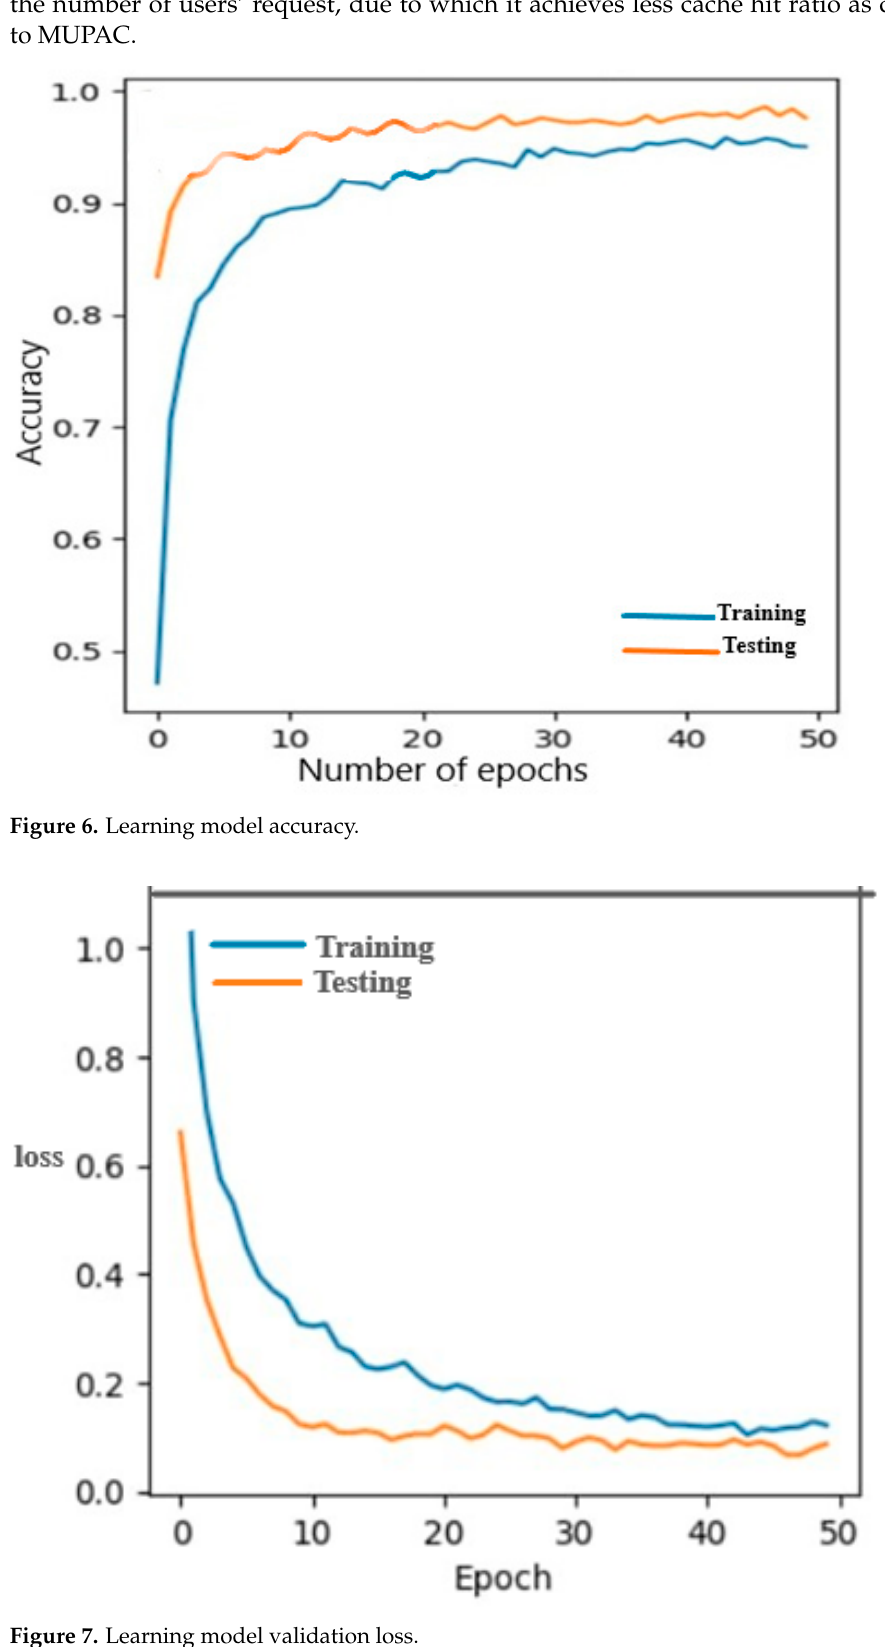
Figure 7. Learning model validation loss.